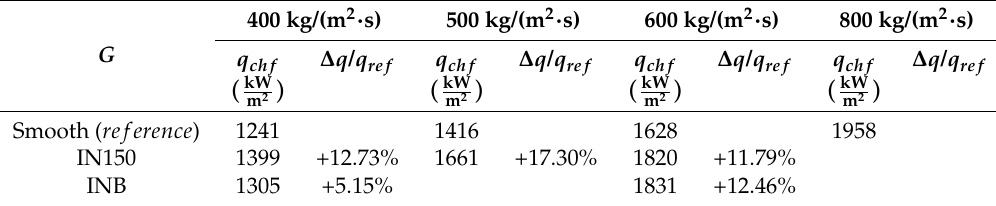
Figure 15. Measured CHF at p out = 120 kPa and T in = 64 °C on four different surfaces in the function of mass flux. Table 9. CHF results of all investigated samples at 120